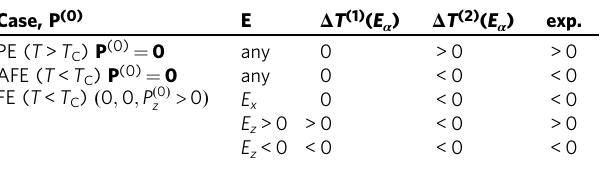
The Table includes the paraelectric (PE), ferroelectric (FE), and antiferroelectric (AFE) states. Shownaretheexpectedsignsofthelinearandquadraticcontributionsto Δ T ( E α )( Δ T (1) ( E α )and Δ T (2) ( E α ) columns, see text), as well as the sign of the experimentally measured Δ T ("exp. ”